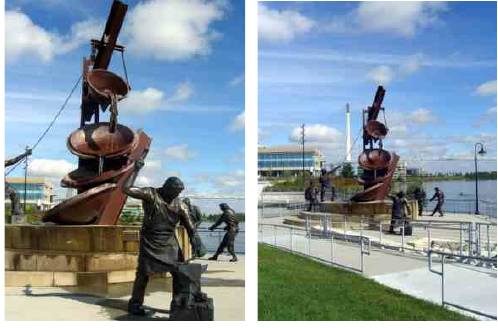
Fig. 8, A monument standing for the energy and integration of Iwa workers Fig. 9, Blacksmith, a memorial for the dedication in